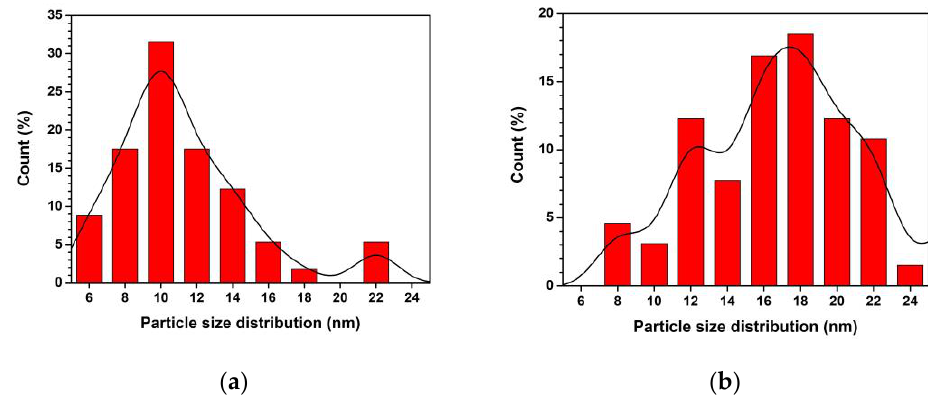
Figure 3. TEM images of ( a ) ZnO and ( b ) Ti-ZnO NPs.